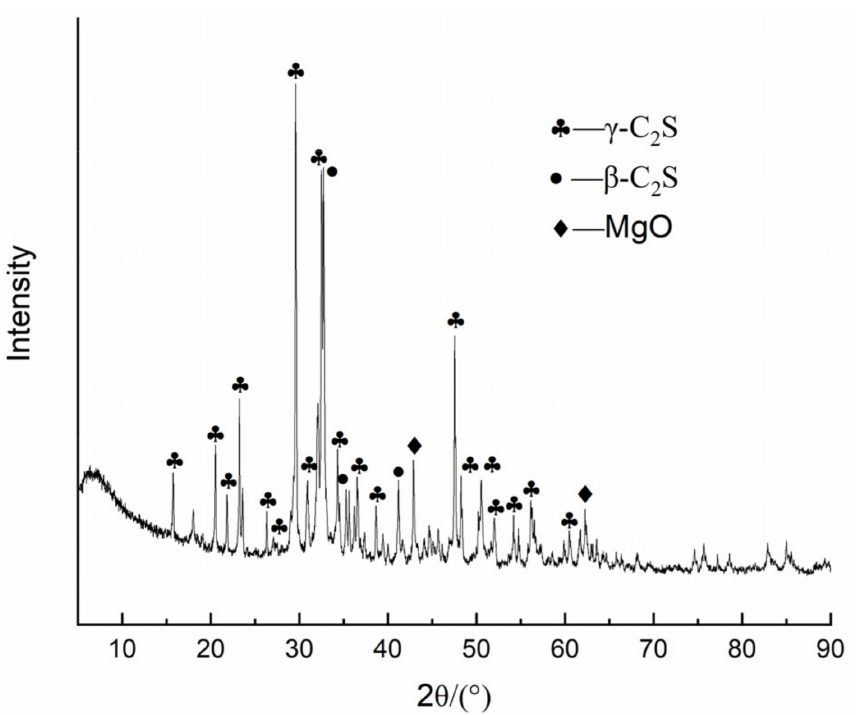
Figure 3. XRD pattern of